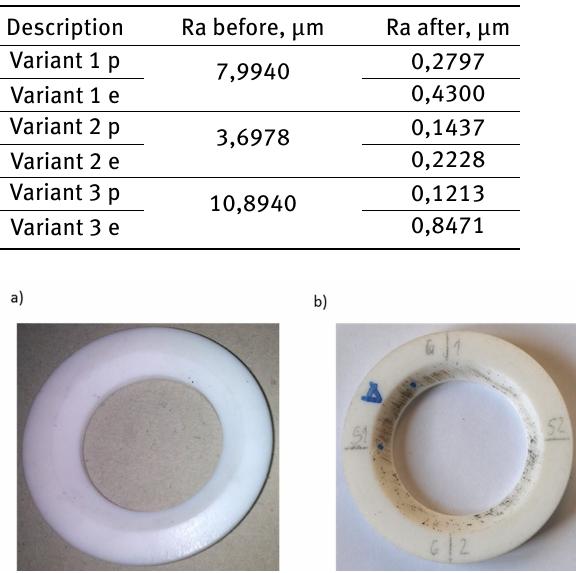
Figure 15: Views of the seal variant 1, a) before the test, b) after the test Table 2: Weight of seal before and after